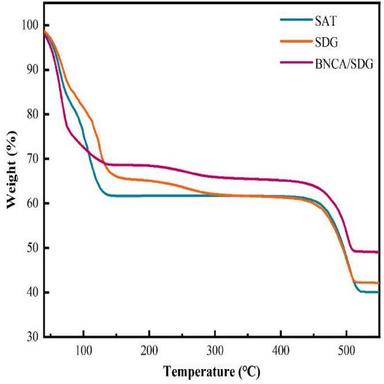
Overlapping TGA curves of SAT, SDG and BNCA/SDG composite PCMs.